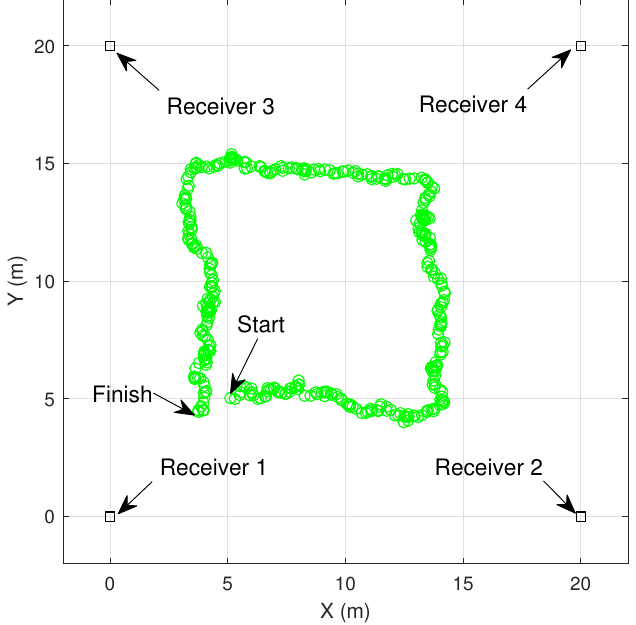
Figure 4. Trajectory of person equipped with mobile